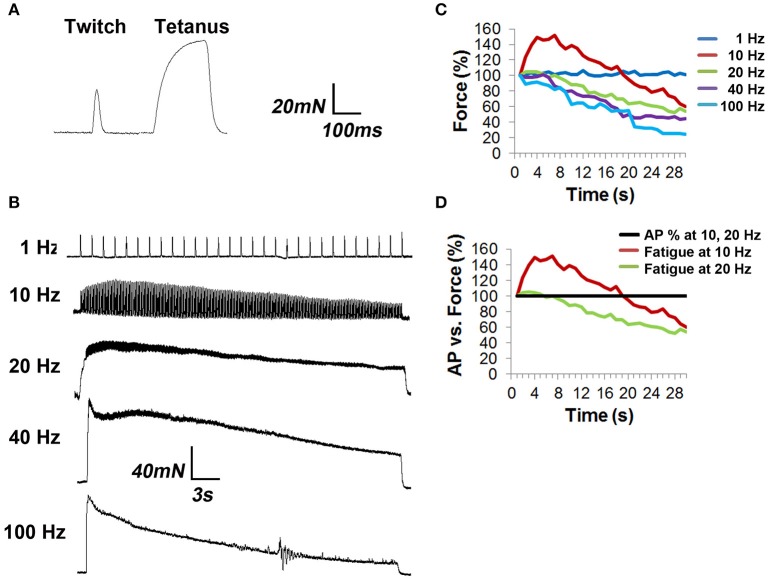
Tension studies in diaphragm strips show fatigue in response to frequencies of nerve stimulation that fail to show neural transmission failure. (A) Diaphragm strips with intact phrenic nerve were excited with single suprathreshold square wave nerve pulses (twitch) or 330 ms of nerve stimulation at 70 Hz (tetanus). (B) Representative traces of diaphragm strip responses to 30 s trains of tonic nerve stimulation at different frequencies. Note the several-second buildup to peak tension in response to 10 Hz stimulation, followed by fatigue, as well as the progressively enhanced fatigue in response to 20, 40, and 100 Hz stimulation. (C) The percent specific force (Force %), over time, in response to different frequencies of HFS, shows that all frequencies above 1 Hz produce fatigue. Error bars left off for clarity. (D) Comparison of force to AP success rate in response to 10 and 20 Hz shows that peak tension declines in the absence of NTF at these frequencies.